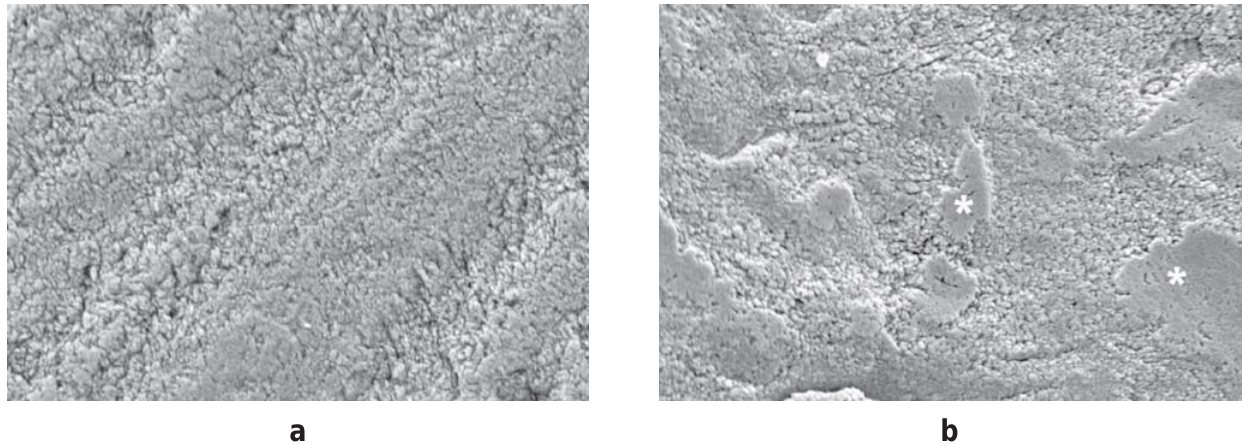
FIGURE 3- SEMs of ground (3a) and intact (3b) enamel surfaces treated with AdheSE self-etching primer. Exposed enamel crystallites were noted in ground surfaces (3a), whereas, the aprismatic layer remnants () were present in intact